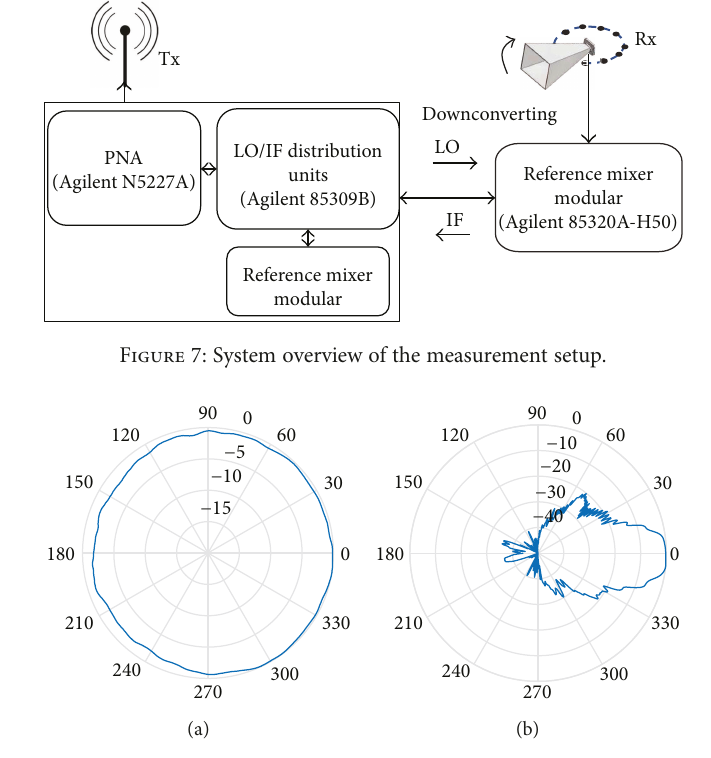
Figure 8: Measured radiation pattern of the biconical antenna (a) and horn antenna (b) in the H-plane at 28 – 30 GHz. The measured antenna pattern of the biconical antenna is quasiomnidirectional, with a maximum deviation of